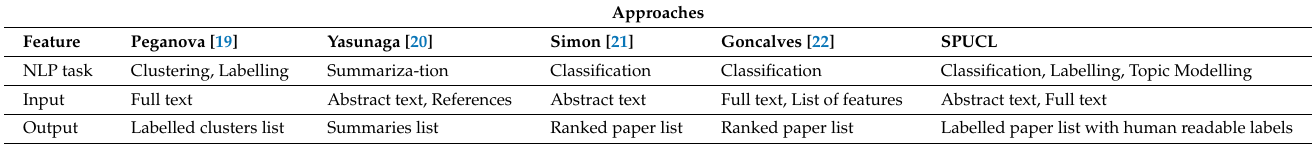
Table 1. Comparison between SPUCL and the other approaches to the document